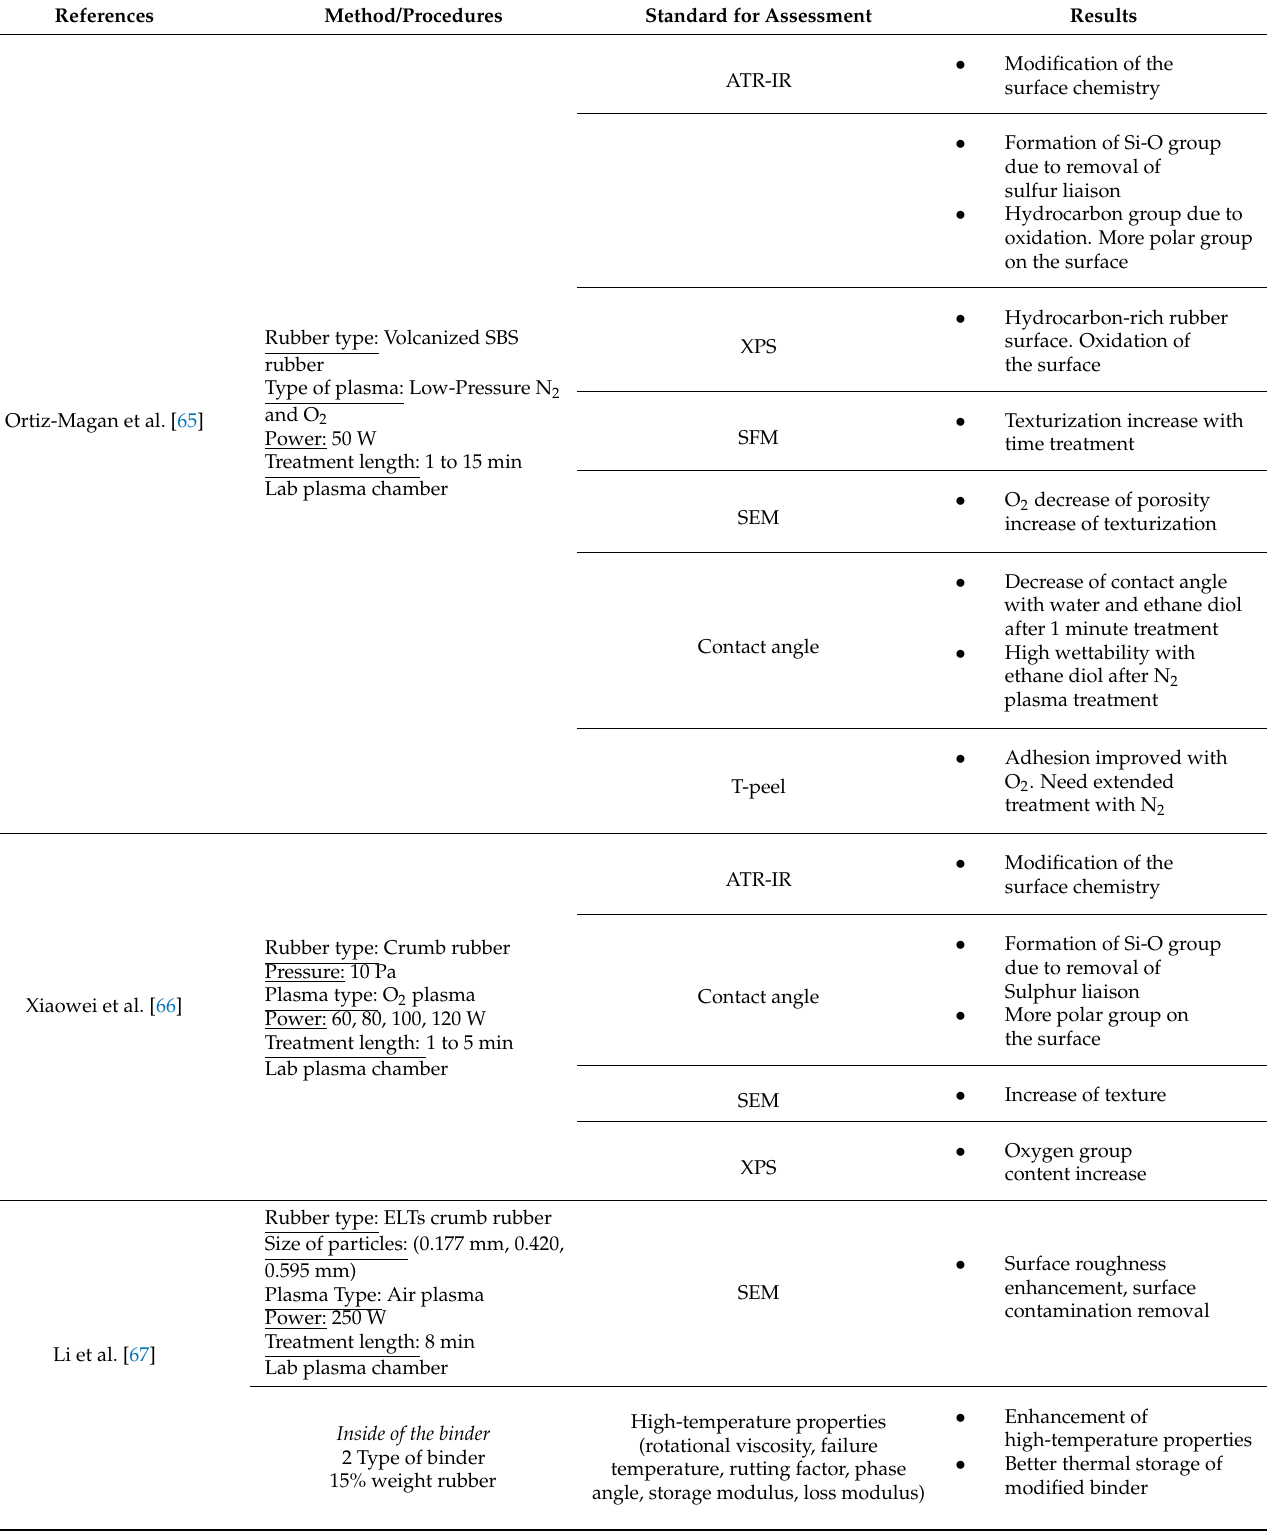
Table 4. Summary of studies on the procedures and results using plasma